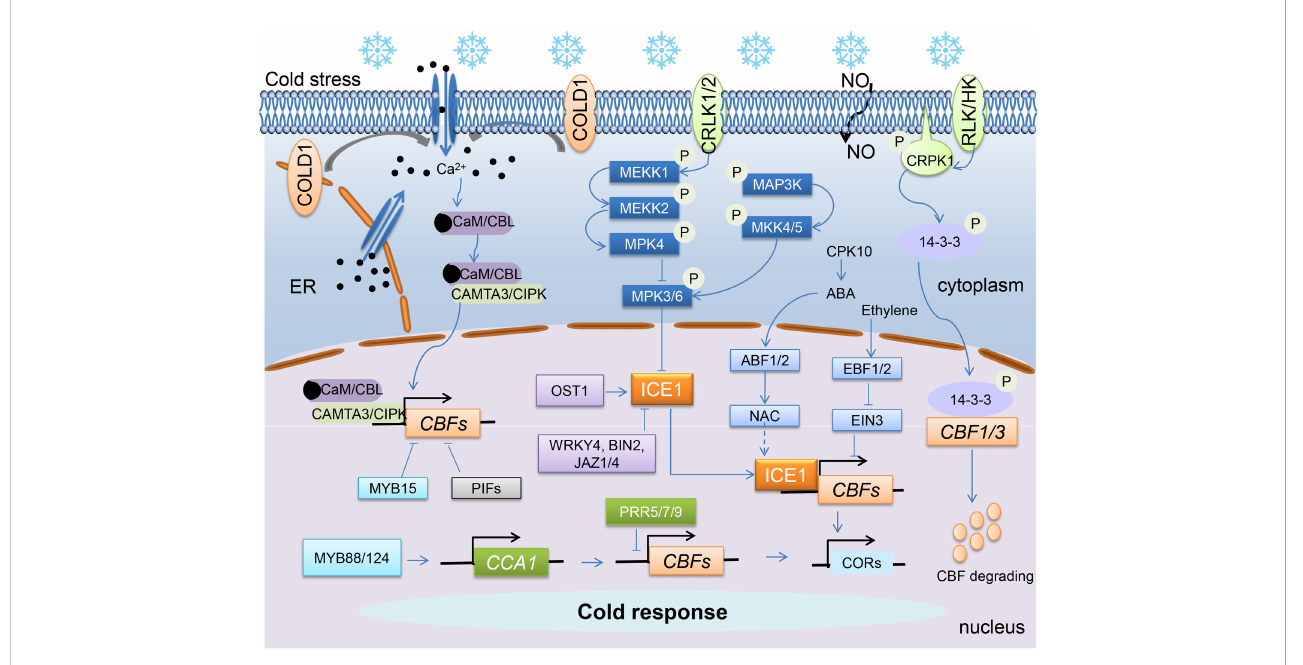
FIGURE 2 Cold sensors and signal transduction in tea and other plant